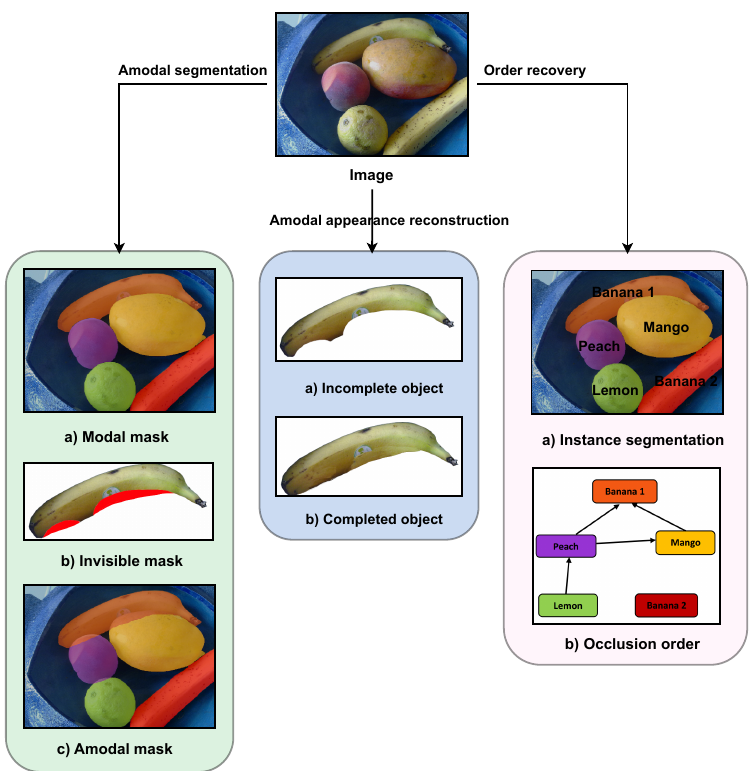
Figure 2. The three sub-tasks in amodal